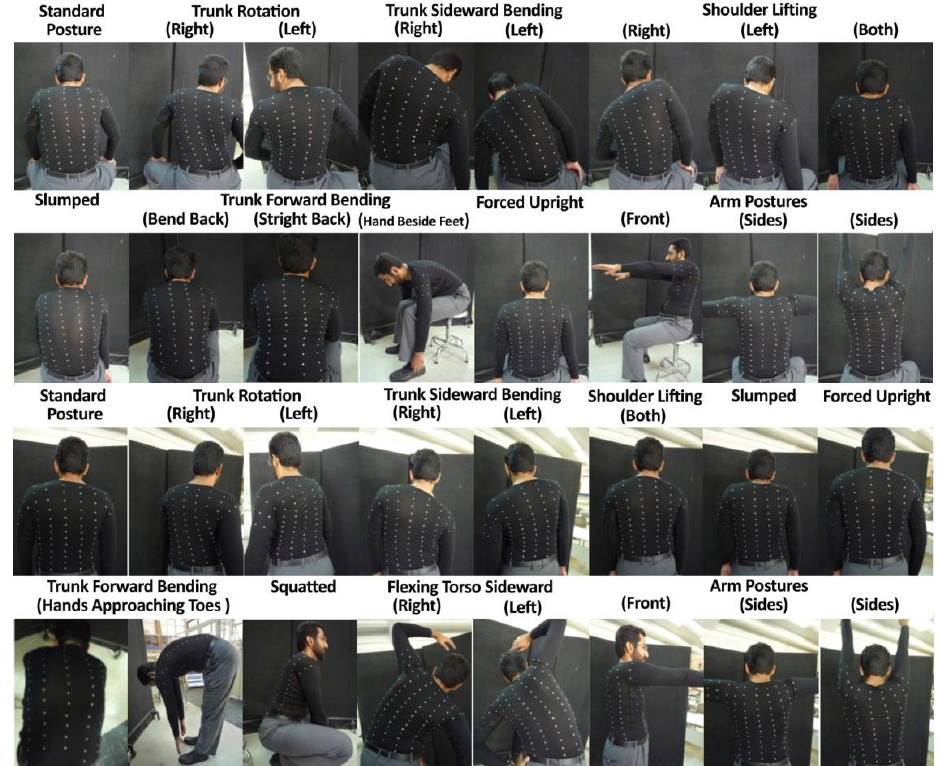
Figure 4. Thirty-two different trunk and shoulder movements used to determine the sensor placement configuration. The pictures were compared to the natural posture. In fact, the path of markers for each movement indicated the elongation direction of each sensor, which was used to determine the best sensor location.